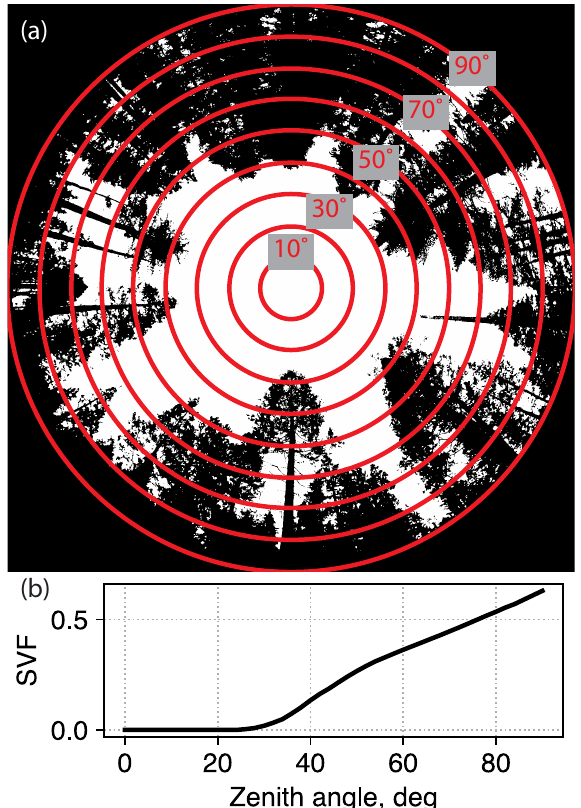
Figure 2. ( a ) An example of the canonical-view image at node F72 in Pinecrest, with zenith angles at 10 ◦ increment specified. ( b ) SVF θ estimated from the image in ( a ), across the full range of zenith angles from 0 ◦ to 90 ◦